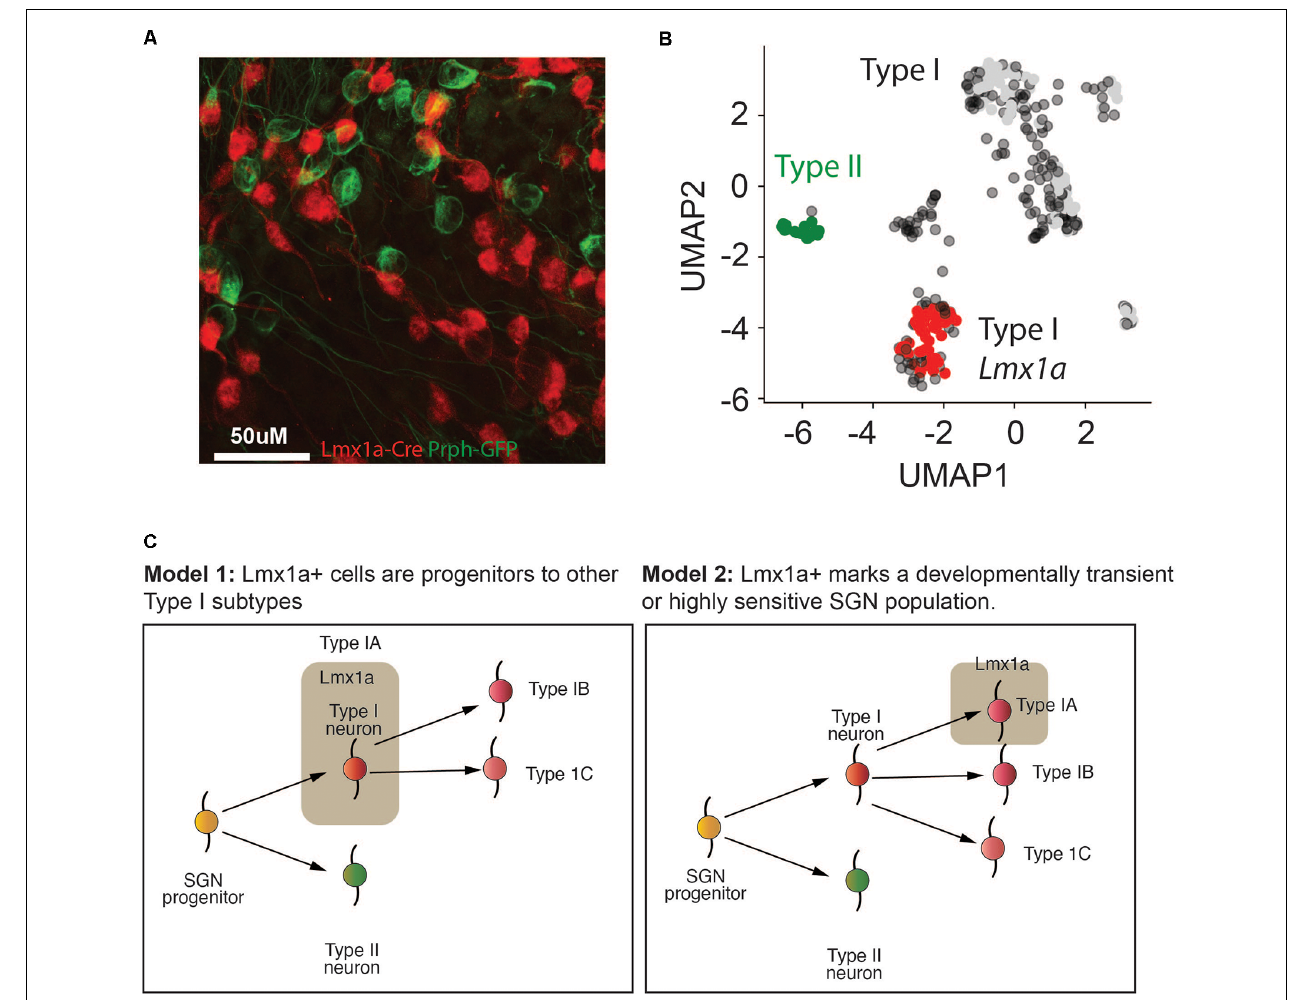
FIGURE 7 | Lmx1a marks a distinct population of Type I SGNs. (A) Representative fluorescent image of Lmx1a -tdTomato x GFP-Prph at P8 from cryopreserved tissue. Magnification at 66 × . (B) UMAP of P8 SGN Type I and Type II cells, colored according to the mouse model in (A) . (C) Two putative models for how the different Type I SGN subtypes identified in this article might form in the cochlea. In model 1, the Type IA Lmx1a cells form an early progenitor population that is more immature and gives rise to the Type IB and Type IC cells, thereby explaining the age-related decline in these cells. In model 2, the Type IA Lmx1a cells are an independent subtype, but they are either more sensitive to stress at later ages, because they are more sensitive, or they are a developmentally transient population that begins to decline by